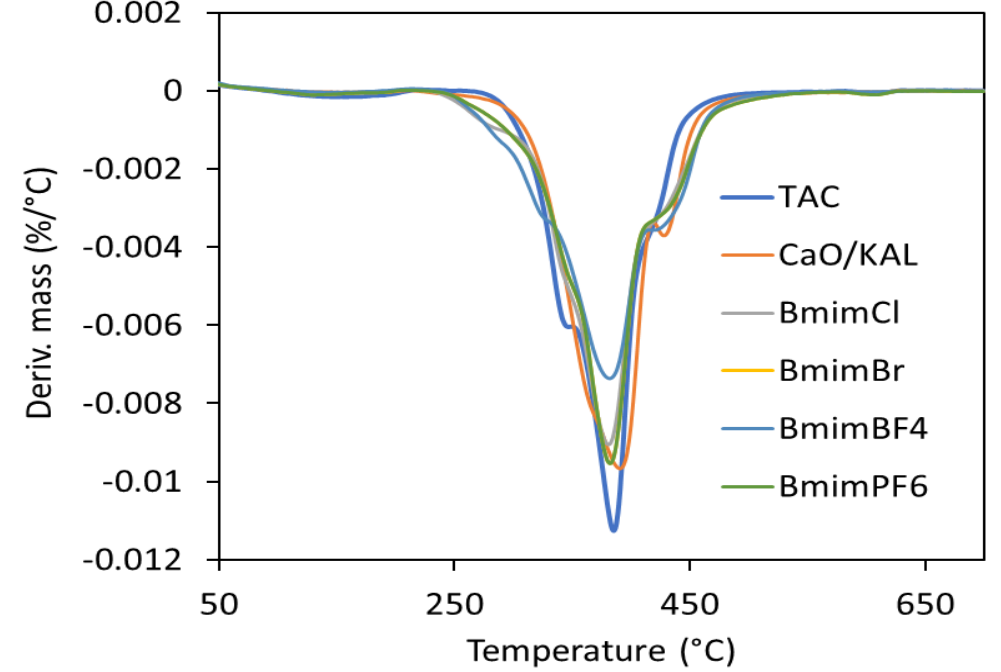
Figure 14. DTG curves of EPM vulcanizates.